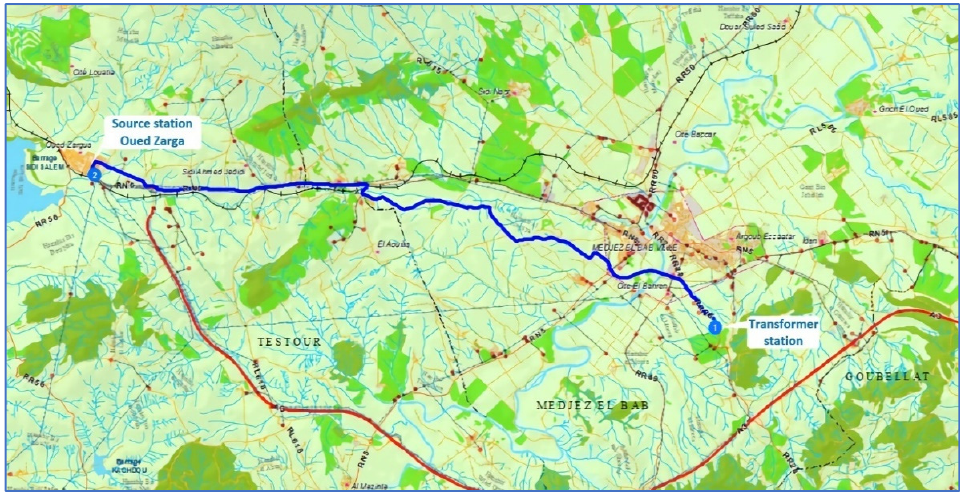
Figure 15. Analysis of the shortest path between the source station and the transformer station.